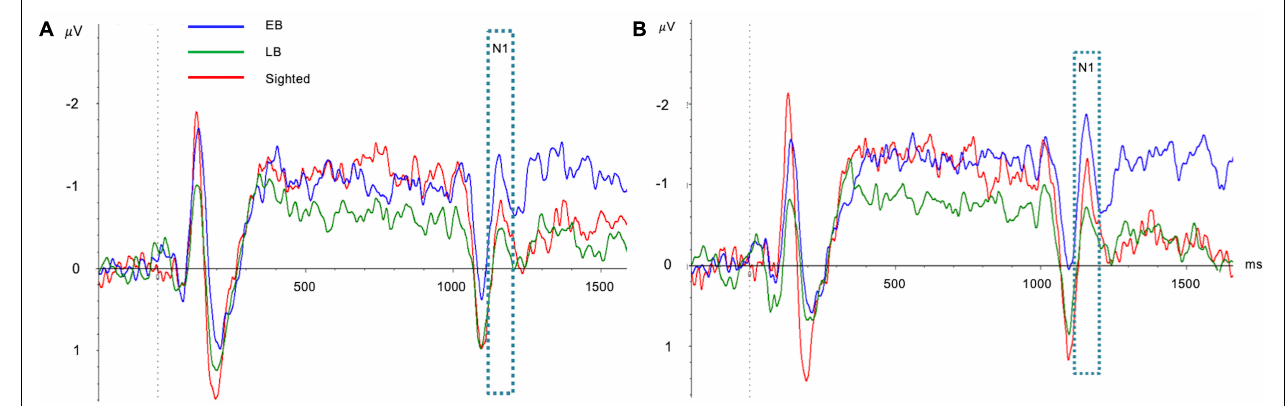
FIGURE 4 | Comparisons of acoustic change complex (ACC) at the Cz (A) and Fz (B) electrodes among early blind (EB), late blind (LB), and sighted subjects. Although the N1 peak amplitude originating from the inverted ripple sound was numerically greater in EB subjects than in LB subjects or sighted subjects, there were no statistically significant